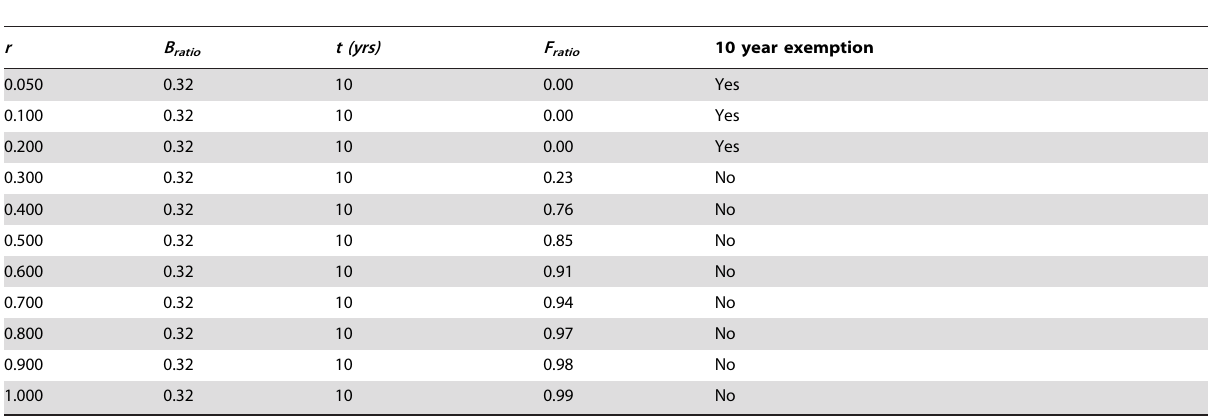
Table 1. A comparison of F ratios (maximum allowed F rebuild / F msy ), given various intrinsic growth rate coefficients ( r ) values, an initial biomass ratio ( B ratio ) of 0.32, and a rebuilding time ( t ) of 10 years.